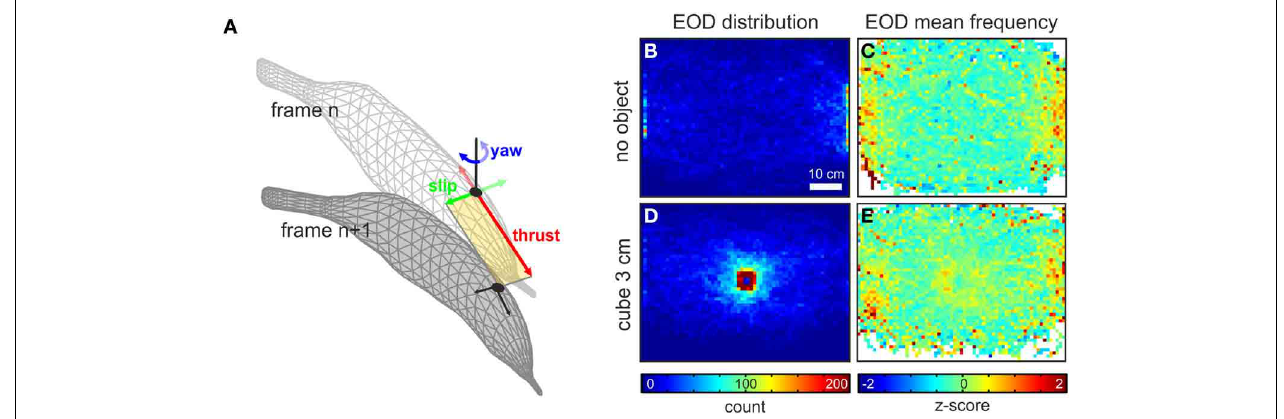
FIGURE 1 | Data extraction from behavioral recordings and spatial aspects of EOD behavior. (A) Principle of the extraction of the kinematic data between two successive video frames. The fish’s head position (black dots) was extracted for each frame. Based on the body orientation, determined from a fit through the animal’s midline, the current heading (orientation) was determined. From this frame of reference (yellow area) the amplitude of the thrust and slip (red and green arrows) was determined as the vectorial components between the current and the successive frame (frame n and frame n + 1). The yaw component (blue arrows) was calculated